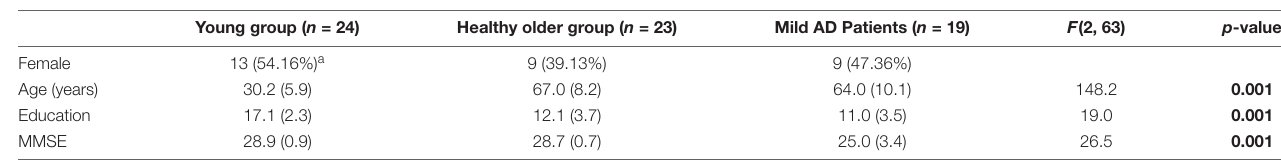
TABLE 1 | Demographics, MMSE scores by group.